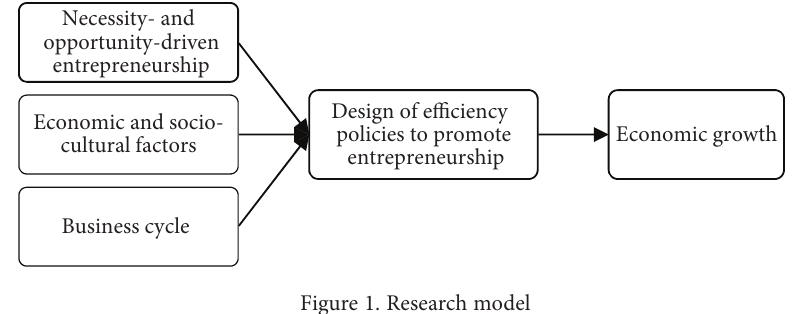
Figure 1. Research